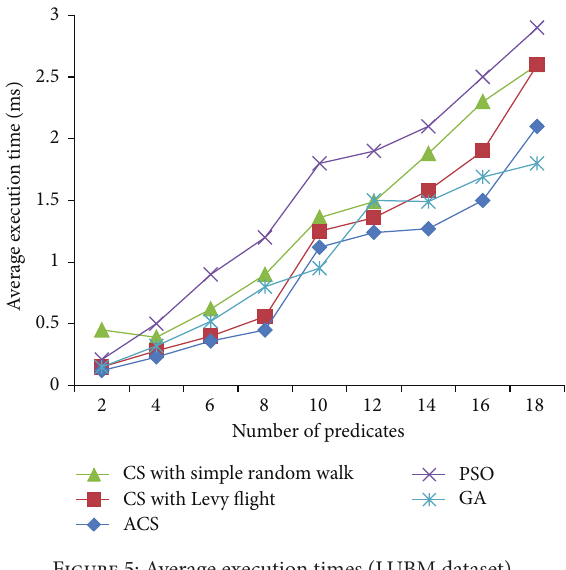
Figure 3: Evolution of best fitness for FOAF dataset.